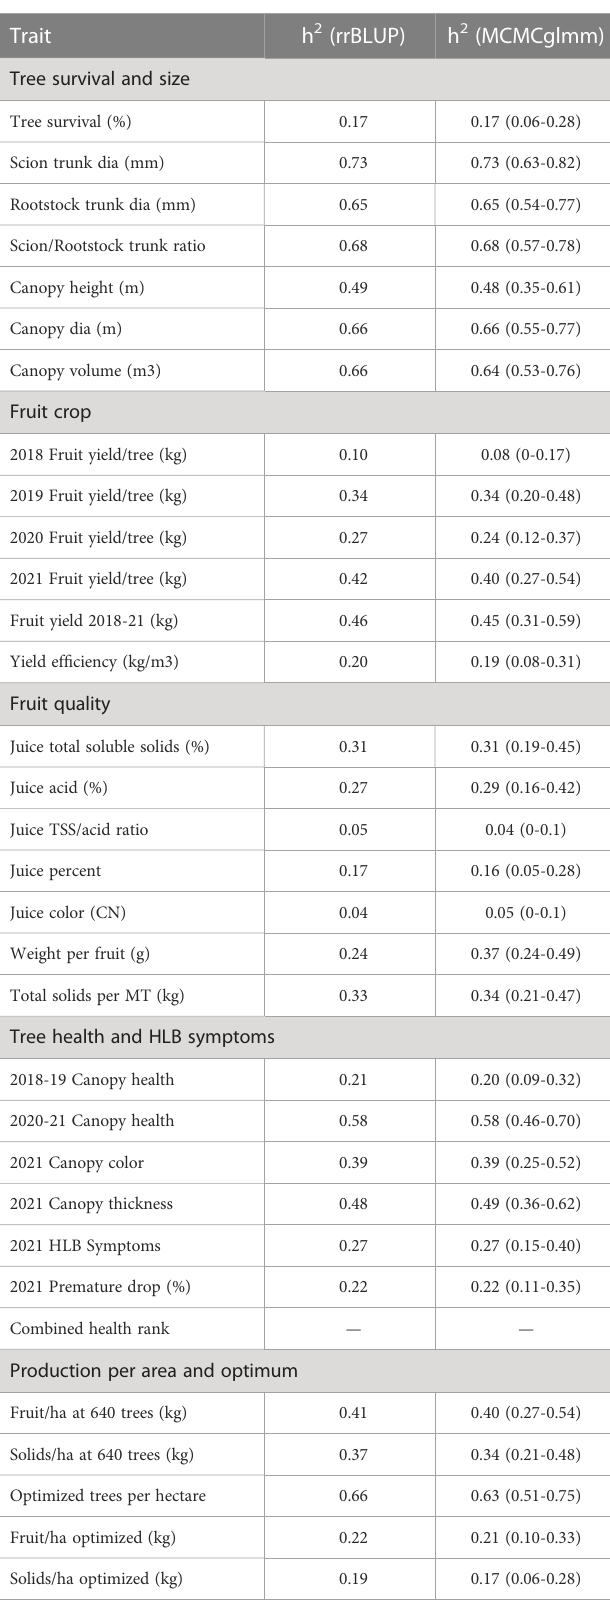
TABLE 8 Heritability (h 2 ) of rootstock traits based on phenotypic performance in the fi eld trial.